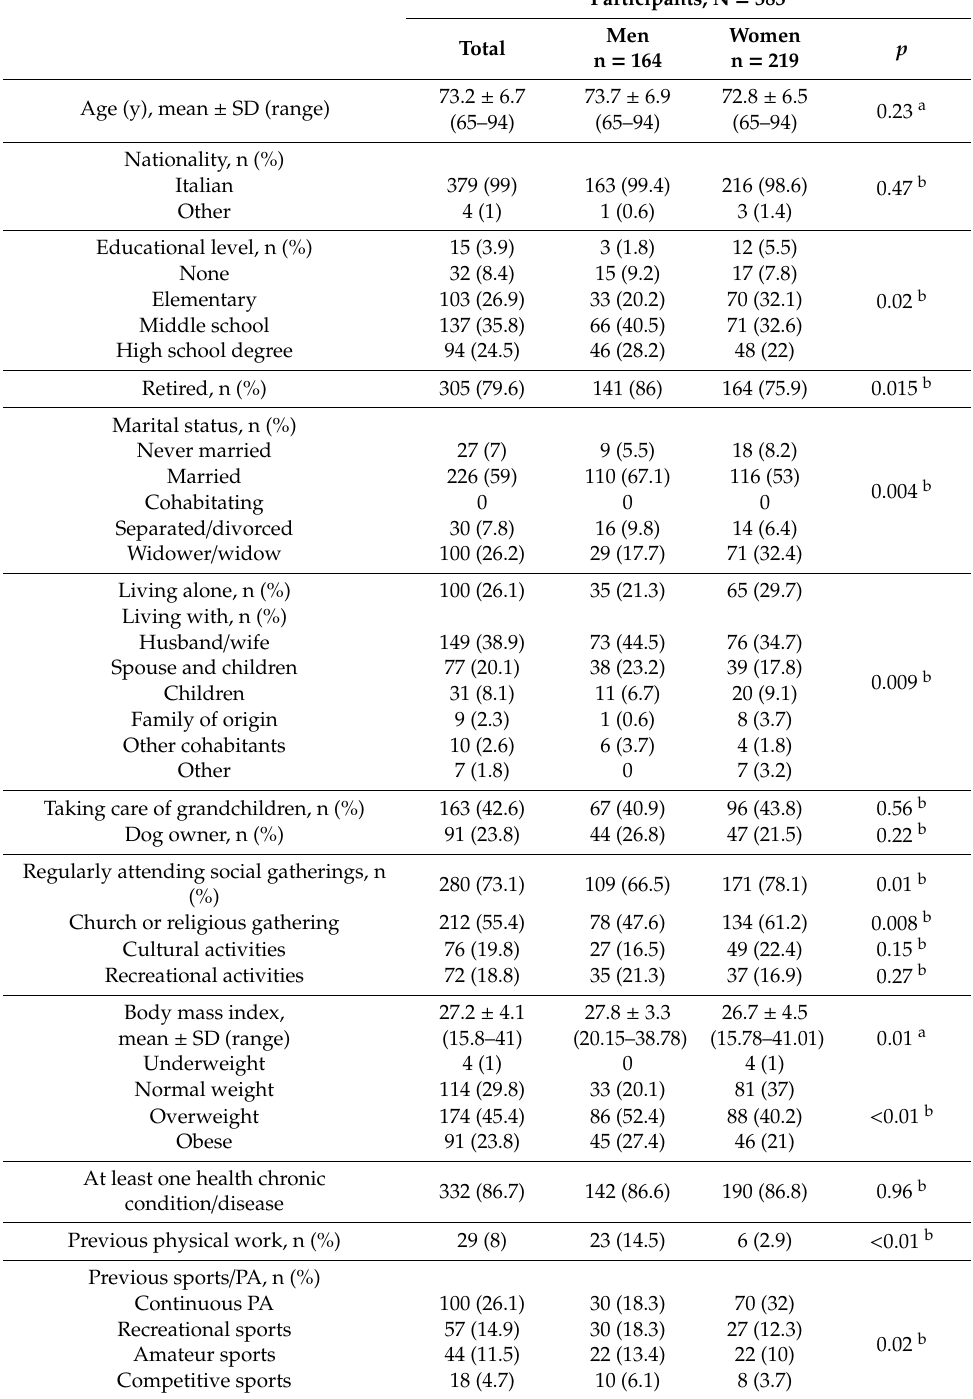
Table 1. Participant characteristics and p values for comparison between groups, by